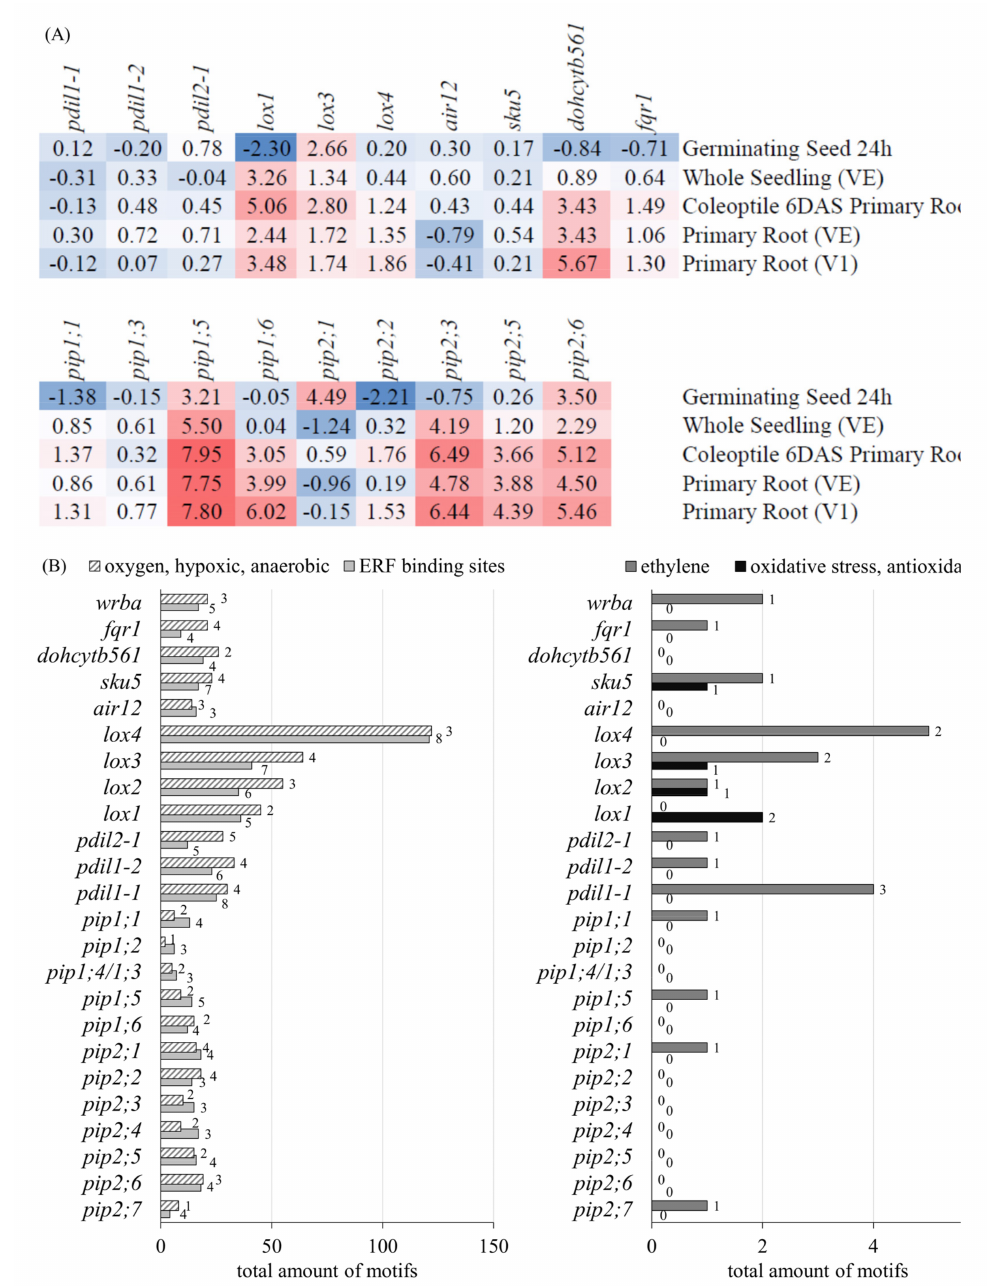
Figure 5. Analysis of PM-bound redox system and PIPs in maize roots. ( A ) Heat map of expression profiles in log2 ratios. Expression profiles, were extracted from Maize eFP Browser. ( B ) Promoter motifs were clustered regarding the keywords anaerobic, hypoxic, and oxygen (shaded bars), binding sites of ethylene-responsive factors including ERE, GCC box, and DRE (light gray bars), ethylene (dark gray bars), and oxidative stress, antioxidants (black bars). The total copy number of all motifs within these three groups is shown in the graph. The bars are labeled with the amount of the different